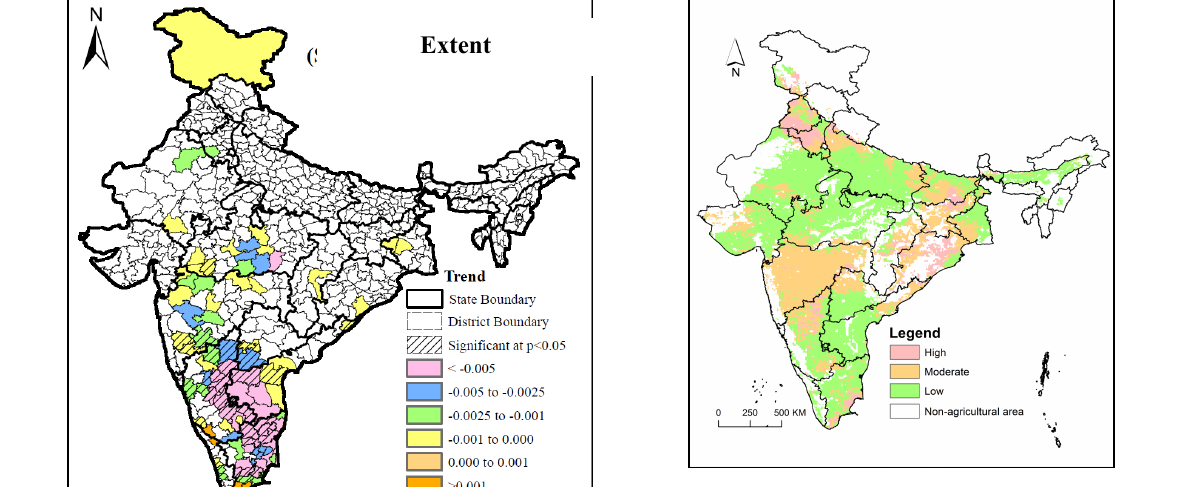
Figure 16 Vulnerability Map of Meteorological Drought During 1993- 2002.